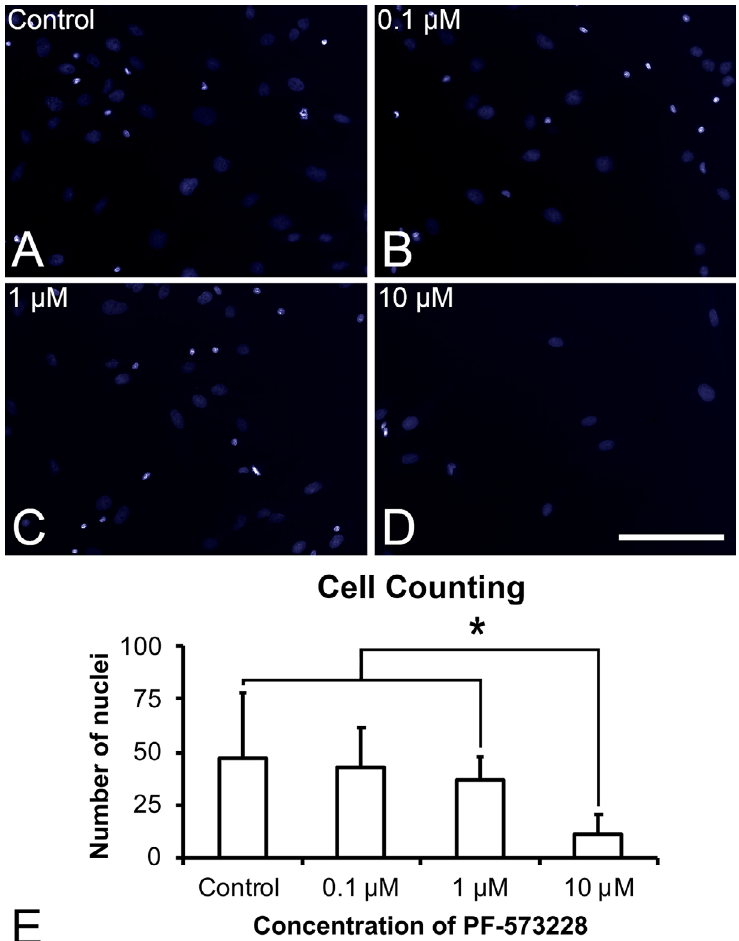
Figure 2- Cell counting of DAPI-positive cells in the control (A), 0.1 µM (B), 1µM (C), and 10 µM (D) PF-573228. The data (E) are presented as mean ± standard deviation (n=9), and asterisks (*) indicate statistically significant differences (p≤0.05). Scale bar: 200